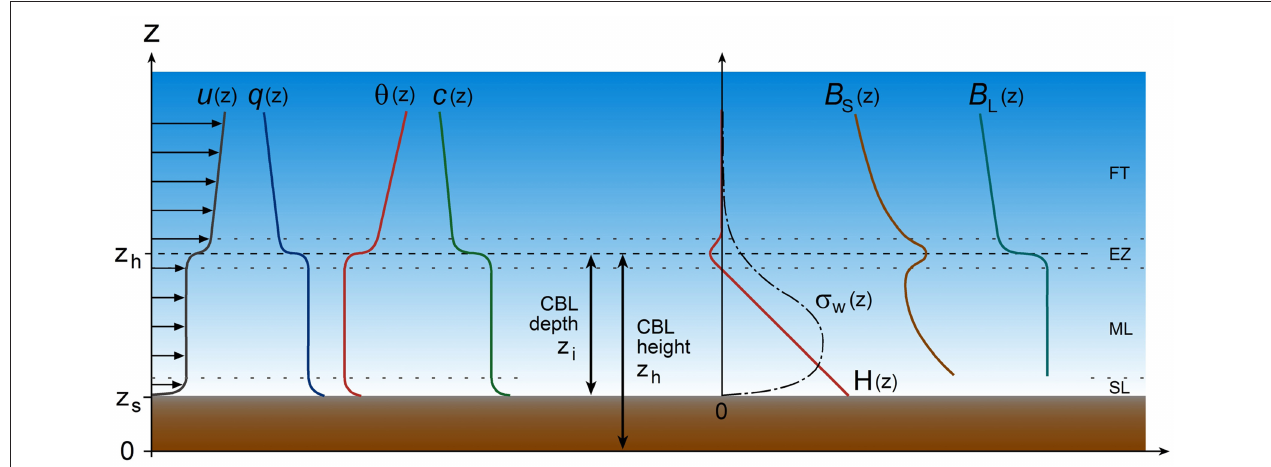
FIGURE 2 | Idealized vertical structure of the lower troposphere under daytime convective conditions over flat and homogeneous terrain, subdivided into the surface layer (SL), the mixed layer (ML), the entrainment zone (EZ), and the free troposphere (FT). The vertical profiles represent wind velocity u(z), specific humidity q(z), potential temperature θ (z), air pollutant concentration c(z), vertical turbulent sensible heat flux H(z), standard deviation of turbulent vertical velocity fluctuations σ w (z), and backscatter signal intensities B S (z) from a sodar and B L (z) from a lidar. z s is the terrain height while z i and z h are the depth and the height of the CBL,